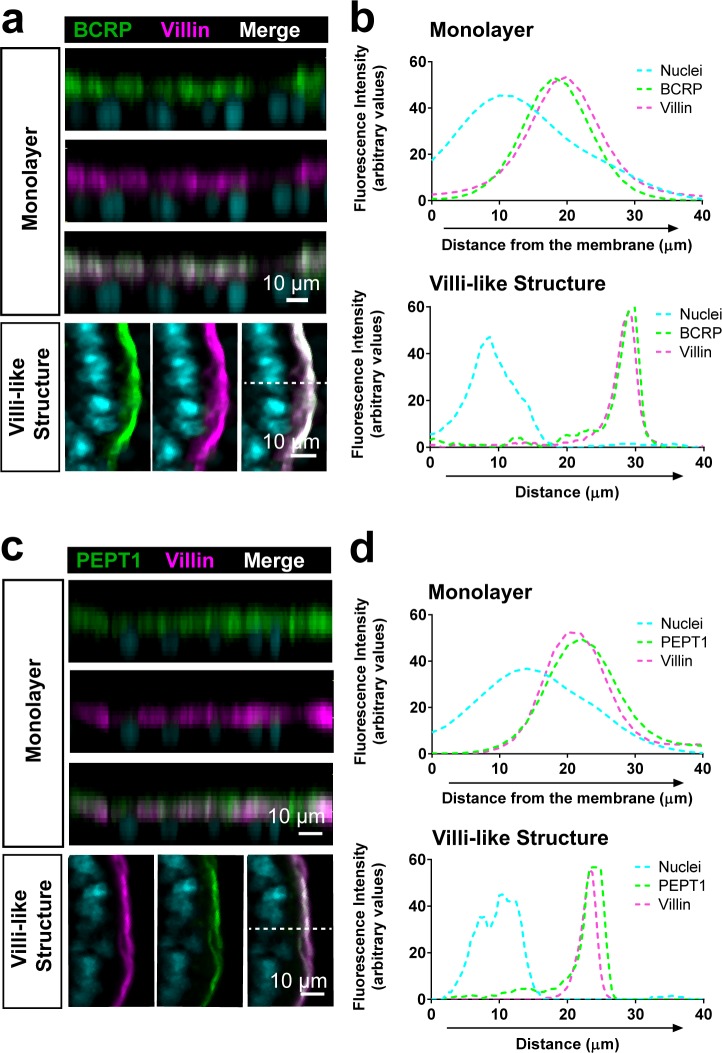
Luminal localization of efflux (BCRP) and uptake (PEPT1) transporters in Duodenum Intestine-Chip.Representative cross-sectional confocal images of Duodenum Intestine-Chip (left) showing apical localization of efflux BCRP (a; green) and uptake PEPT1 drug transporters (c; green) that co-localize with luminal cell surface marker villin (magenta) at the time of confluent monolayer formation (day 4 of culture) as well as within successively formed villi-like structures (at day 8). Cell nuclei are visualized in cyan. Scale bar, 10 µm (b and d) Line plots corresponding to confocal images in (a andb) representing distribution of the fluorescence intensities across epithelial cell z-axis revealed close overlap of green (transporters; BRCP and PEPT1) and magenta (apical cell marker; villin) signals confirming co-distribution of these proteins on the luminal cell surface. The fluorescent intensity for each channel was analyzed in 3D reconstructed confocal images of Duodenum Intestine-Chip and plotted as average across 26 different z-stacks (for BCRP) and 21 different z-stacks (for PEPT1).